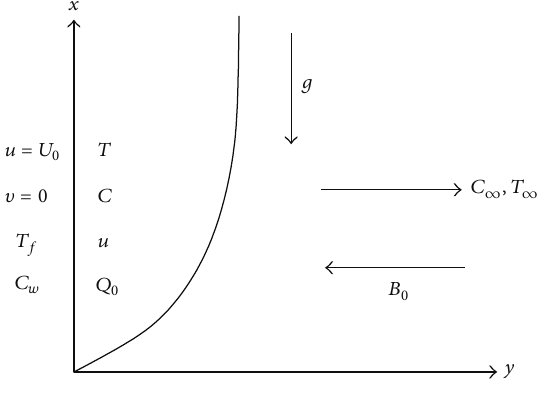
Figure 1: Sketch of flow geometry.